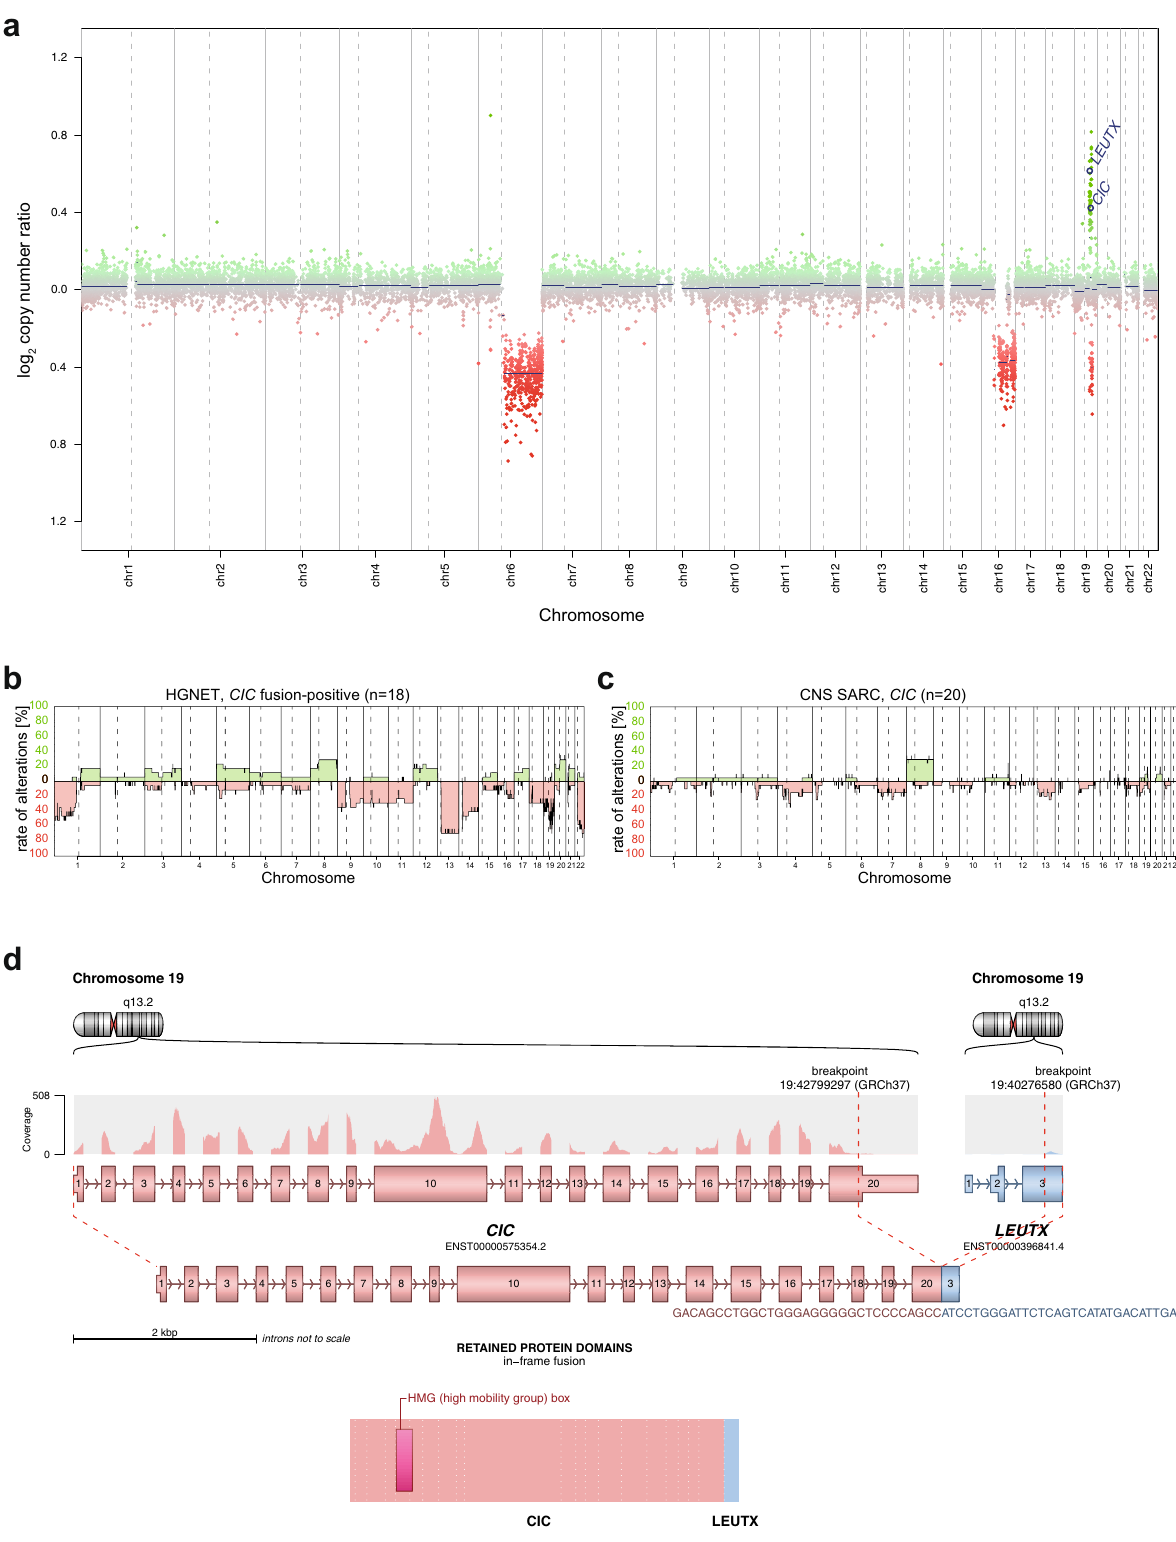
Fig. 2 Molecular characteristics of high-grade neuroepithelial tumors CIC fusion-positive (HGNET, CIC fusion-positive). a Copy number pro fi le derived from DNA methylation array data of a HGNET, CIC fusion-positive showing structural alterations affecting chromosome 19q around the CIC and LEUTX locus. b , c Summary plot of copy number alterations in HGNET, CIC fusion-positive and CIC -rearranged sarcoma (CNS SARC, CIC ). d Visualization of the CIC::LEUTX gene fusion detected by RNA sequencing, in which exons 1 – 20 of CIC , as the 5 ′ partner, are fused to exon 3 of LEUTX